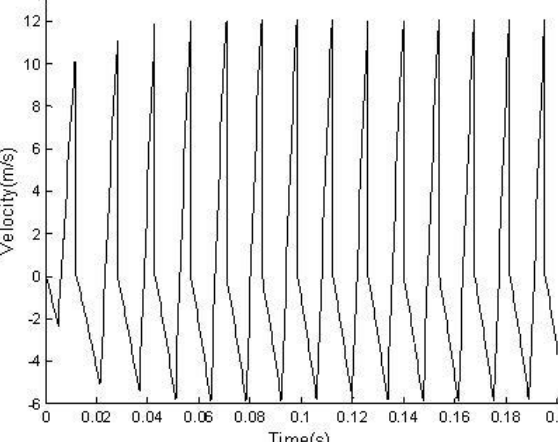
Figure 8. Velocity curve of impact piston under rated working condition.